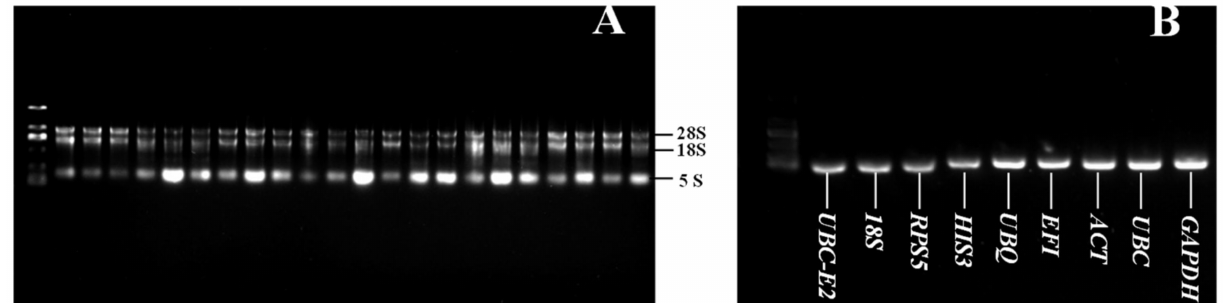
Figure 1. Garlic RNA samples ( A ) and amplification products of candidate reference genes ( B ) detected by agarose electrophoresis.